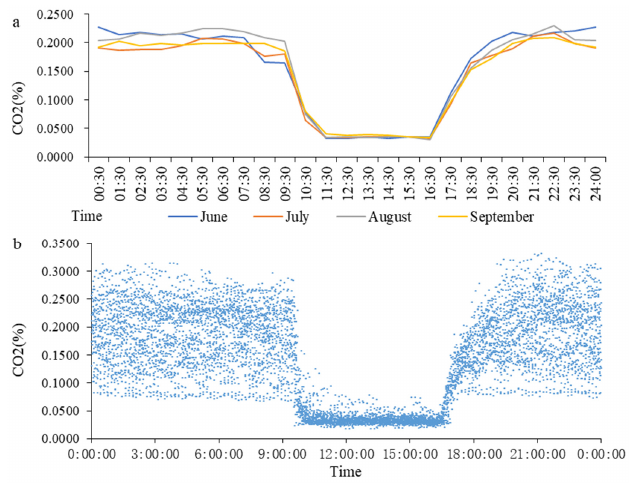
Figure 2. The variation trends in CO 2 concentration in the treatment group. ( a ): The variation trends in CO 2 concentration in different months; ( b ): summary of data of CO 2 concentration.